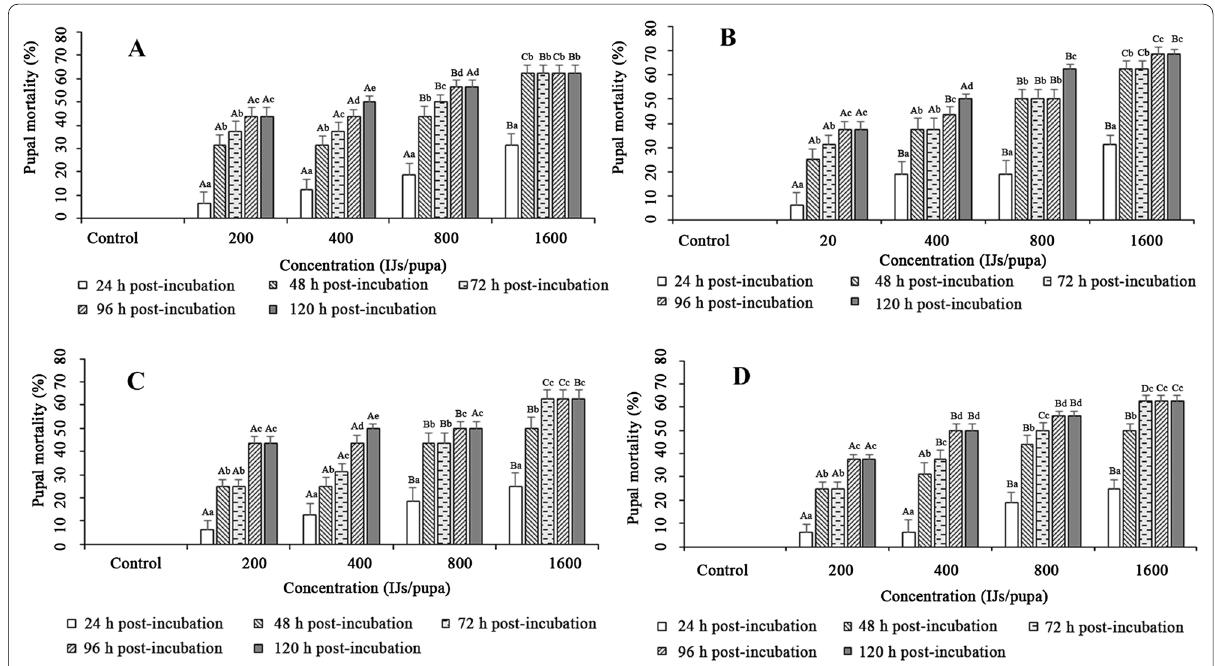
Fig. 4 Percentage mortality of the pupa of Spodoptera frugiperda upon exposure to different concentrations of nematodes. A Heterorhabditis indica , B H. baujardi , C Steinernema sangi and D S. surkhetense